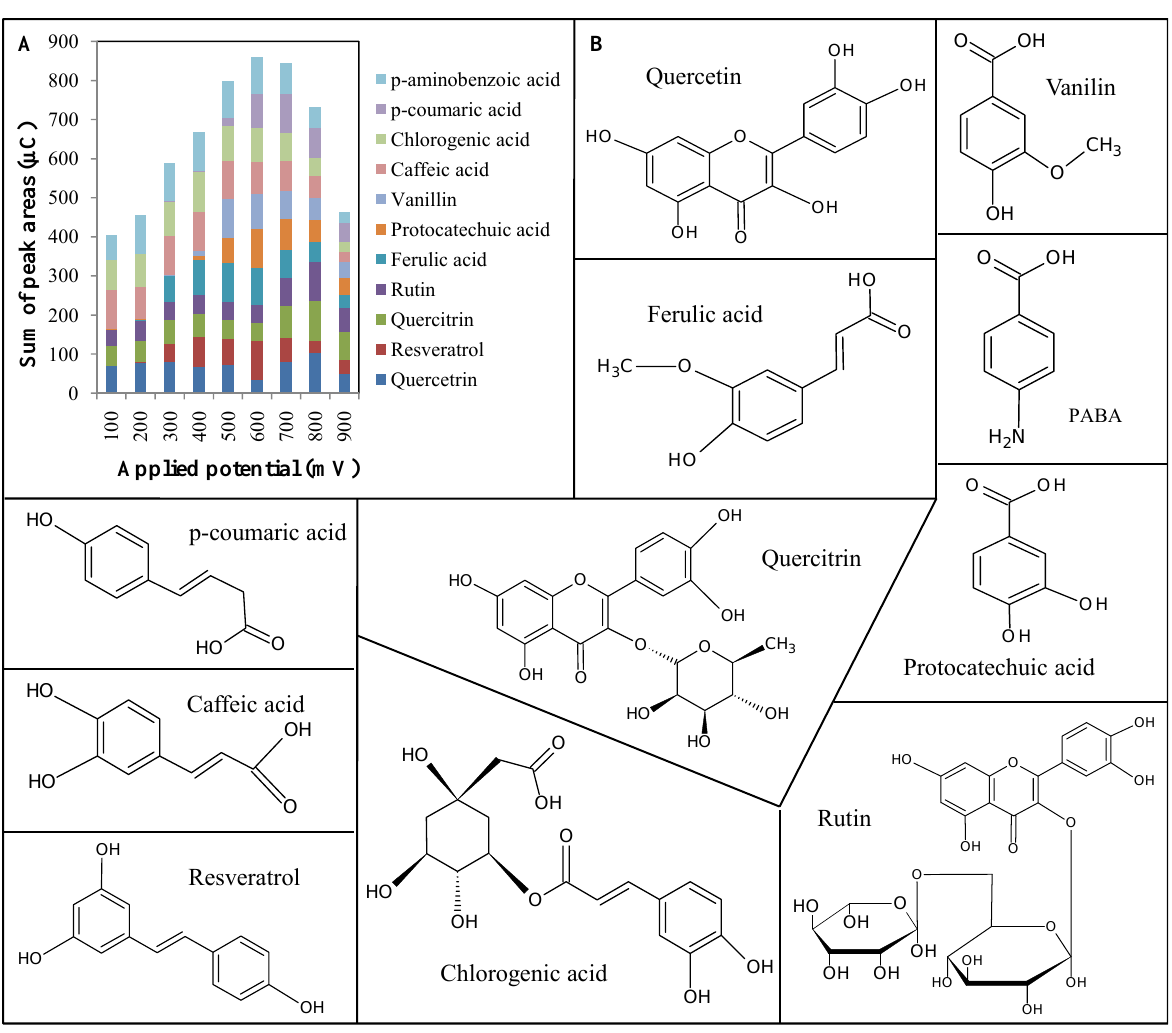
Figure 2. (a) Electrochemical response of applied potential on peak areas. Sum of peak areas show that the highest yield of extraction was at 600 mV potential. Areas of single peak of polyphenols show their extraction efficiency. Low potential did not provide protocatechuic acid detection. (b) Chemical structures of chosen